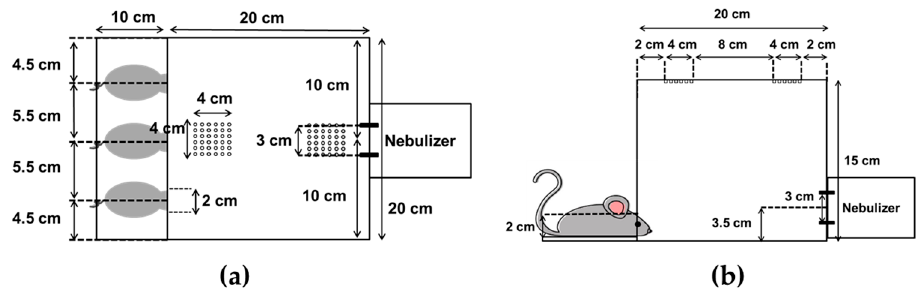
Figure 1. A head-only exposure chamber system for mice: ( a ) top view and ( b ) side view.